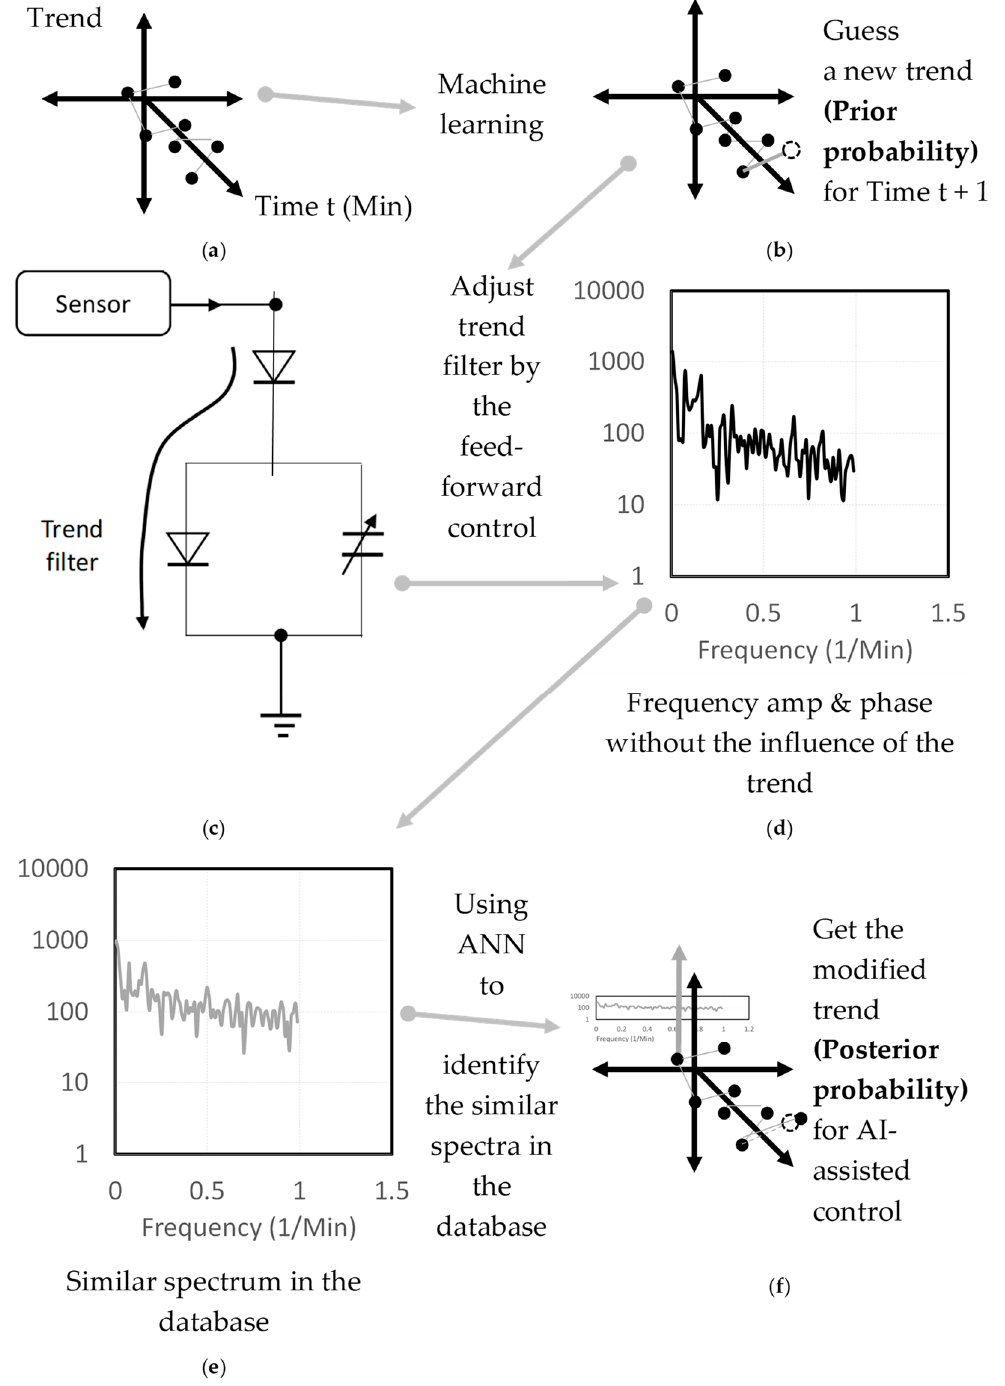
Figure 6. Working principles of the AI-assisted HVAC control ( a ) Trend from the big data collection; ( b ) Initial guess of the trend by machine learning; ( c ) Adjustment of the trend filter for the PIN sensor; ( d ) Frequency output; ( e ) Comparing with a similar spectrum; ( f ) Modified trend for the AI-assisted control.